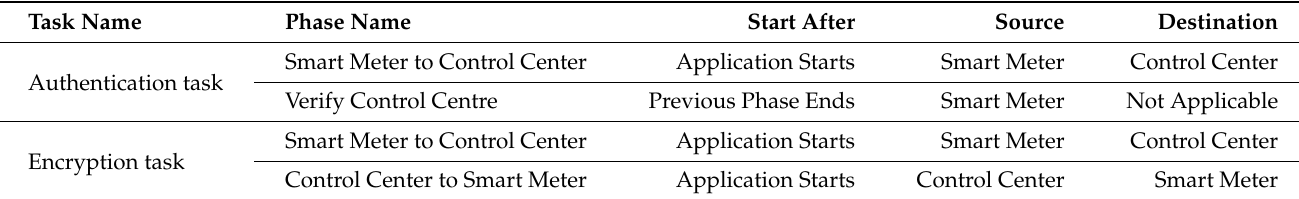
Table 1. The phases’